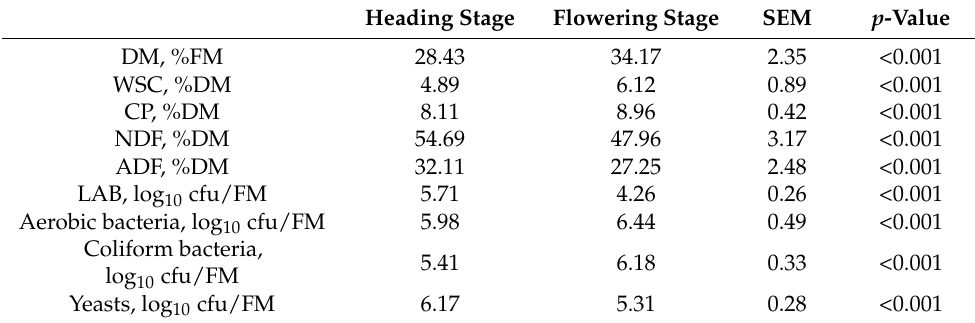
Table 1. Chemical and microbial compositions of perennial